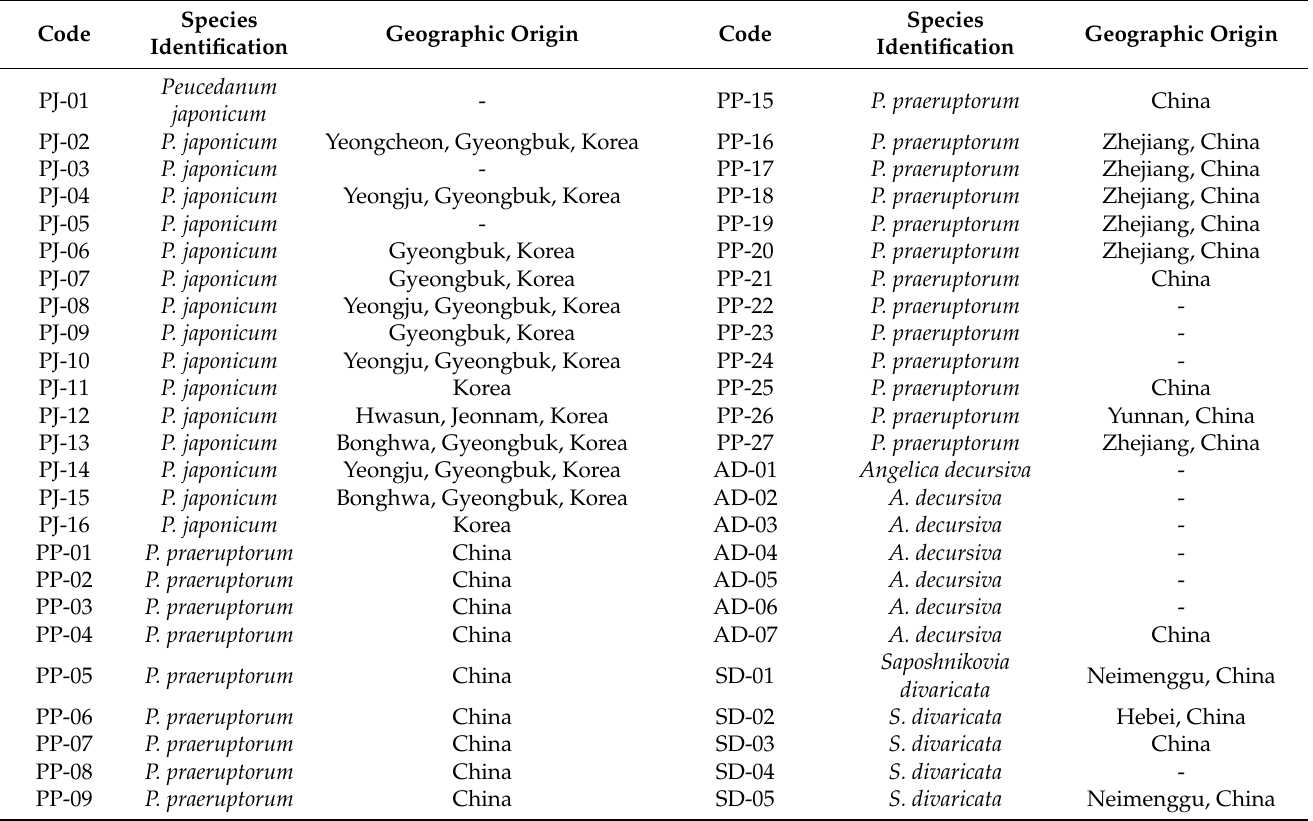
Table 1. Species identification of the samples using the combined five DNA barcode